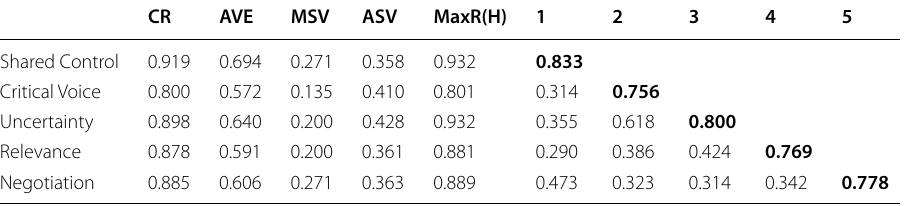
The diagonal values in bold are the square root of AVE while values below it are correlation between the respective constructs. CR composite reliability; AVE = shared variance;